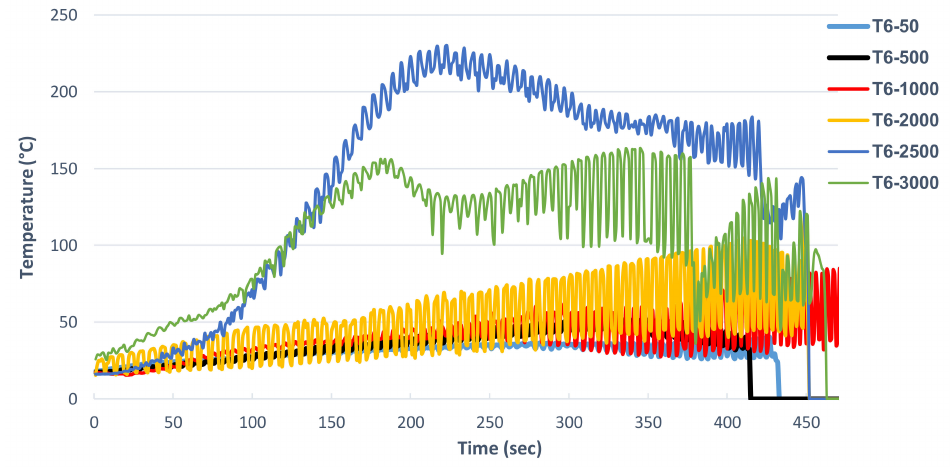
Figure 8. Temperature profiles at varying rotational speed, as observed during ISF of T6 AA-2219